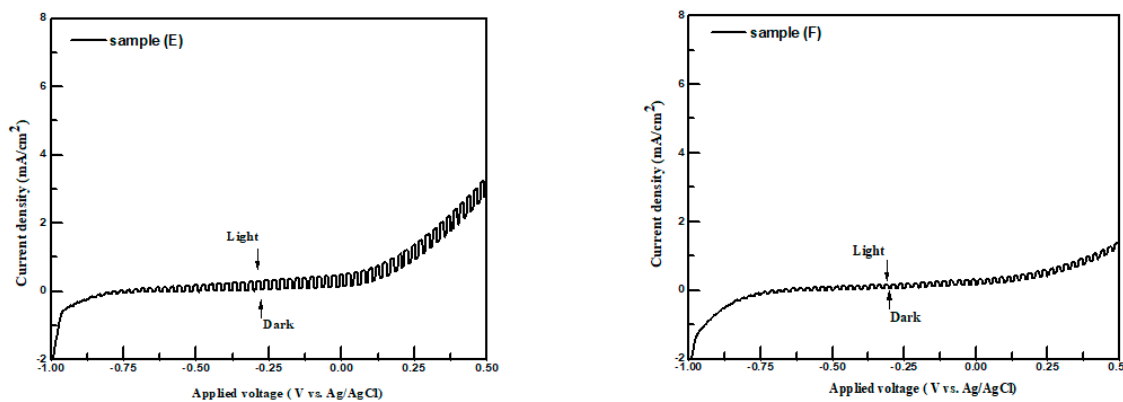
Figure 7. Current density-applied voltage plots for samples in the aqueous 0.25 M Na 2 S + 0.35 M K 2 SO 3 solution.